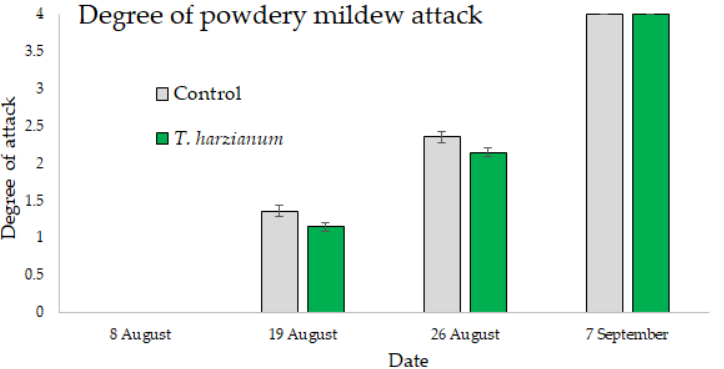
Figure 8. Mean values (± standard errors) of the powdery mildew degree of attack in plants inoculated with T. harzianum T22 and control over time.